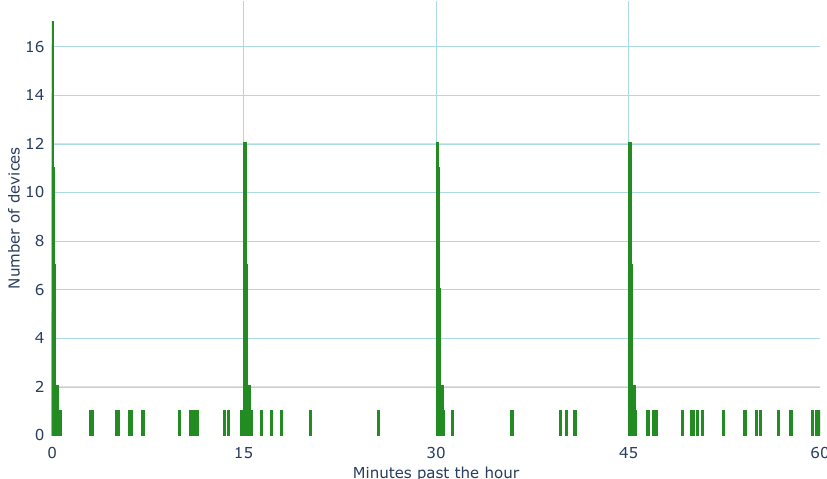
Figure 3. All the end nodes transmit data hourly or more frequently. This figure shows the number of devices that transmit within the same second past the hour (excluding node rh-1 ). These are not LoRaWAN transmit collisions, but rather, an indication for potential